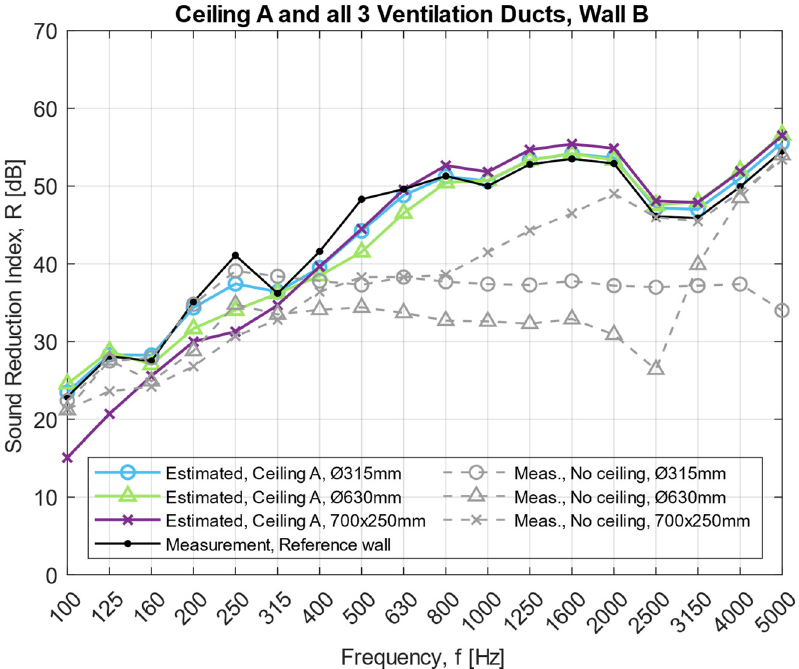
Figure A6. Estimated theory with suspended absorbent ceiling, Ceiling A, as acoustical treatment. Ventilation duct with dimensions of: Ø315, Ø630 and 700 × 250 mm through wall B with a sound reduction index of 𝑅 (cid:3050) = 46 dB.